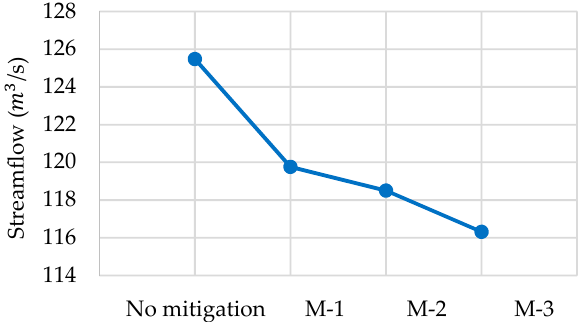
Figure 23. Simulated streamflow in the case of land cover mitigation in the Hemrin Watershed.